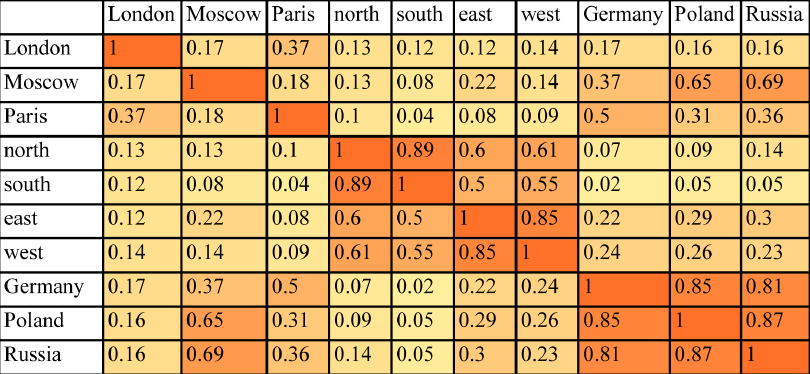
Figure 4. Similarity scores computed using LSA for the words { London,Moscow,Paris,north,south,east,west,Germany,Poland,Russia } shown as a heat map.